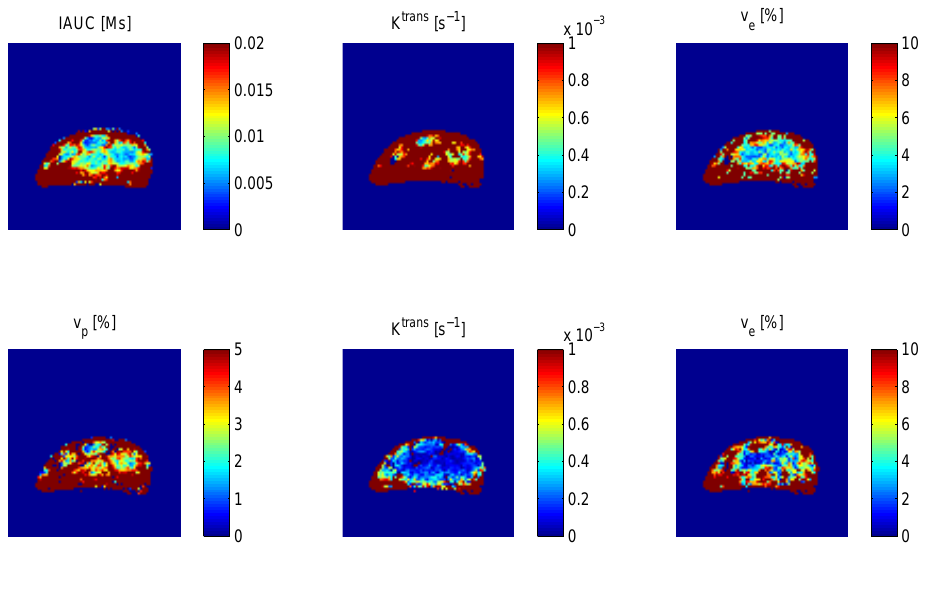
Figure 3. Parametric maps of IAUC (90 s) and parameters from Toft’s model excluding ( upper ) and including ( lower ) blood volume fraction v mammary